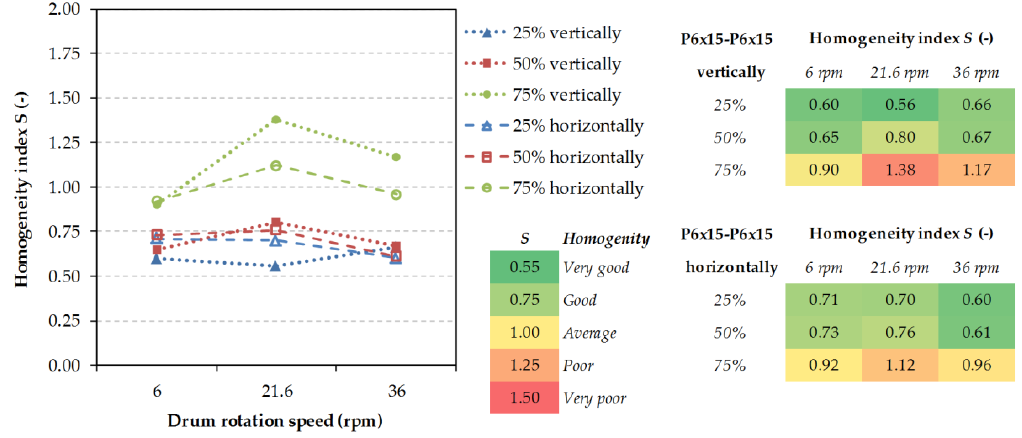
Figure 12. Resulting homogeneity indices for different operating conditions (P6 × 15-P6 × 15 particles).